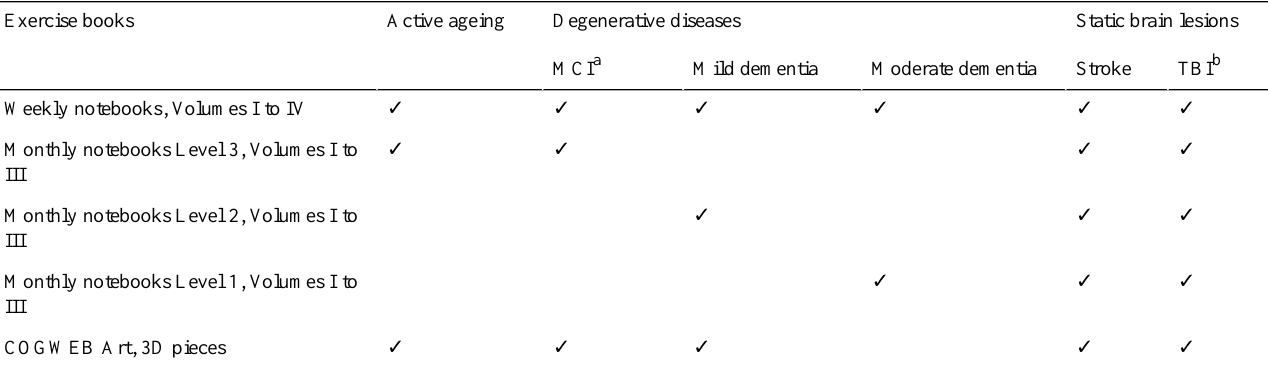
Table 3. Exercise books available and their target population.